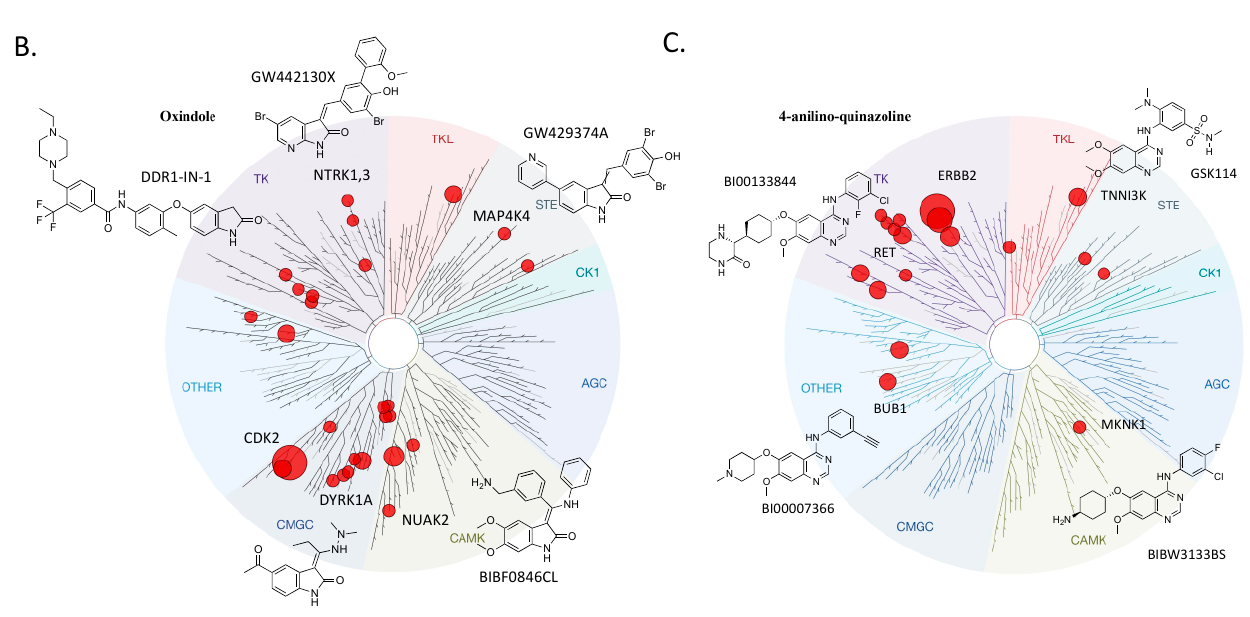
Figure 2. KCGS contains inhibitors from 67 distinct chemotypes. ( A ) This graph displays the number of inhibitors in each SMILES arbitrary target specification (SMARTS) bin. The numbers above the left-most 9 bars represent the number of FDA approved kinase inhibitors in these chemotype bins at the time the manuscript was written. The inset provides names of the 9 most highly populated bins. ( B ) Tree plot of the human kinases with each subfamily uniquely shaded. Kinases covered by a member of the oxindole SMARTS bin are displayed as red dots, scaled by the number of compounds inhibiting a specific kinase. Representative chemical structures form the oxindole SMARTS bin are shown. ( C ) Kinases covered by the 4-anilino-quinazoline SMARTS bin with representative chemical structures. (# = number)